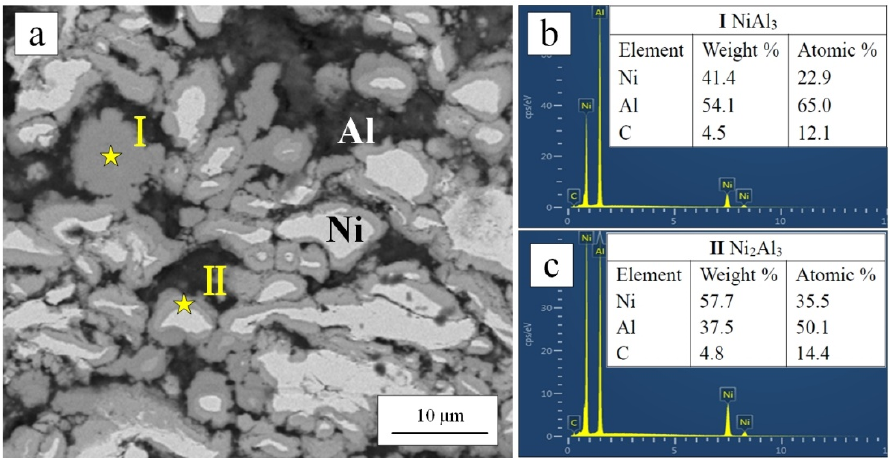
Figure 8. Backscattered SEM images of the cross-section of diamond/Ni/Al coating after 400 °C heat-treatment and the selected point ( Ⅰ ) and point ( Ⅱ ) at Ni-Al reaction products for EDS test ( a ); ( b , c ) showing the EDS results of the selected points.